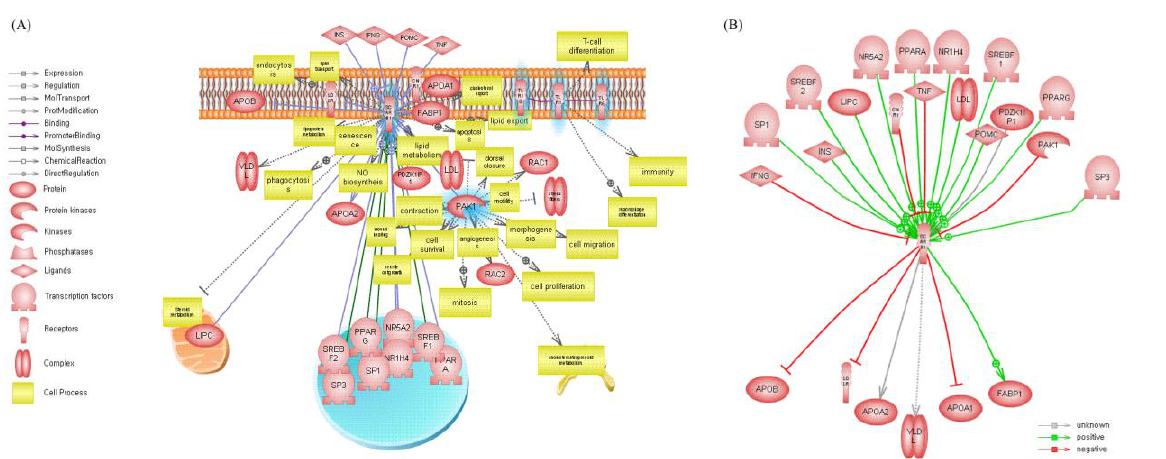
Figure 2. Pathway analysis of the candidate genes. (A) Direct interactions between candidate genes and their regulatory relationships. Blue highlight marked genes indicates candidate genes for from QTL analysis. (B) The SCARB1’s under up- and down-stream levels of the